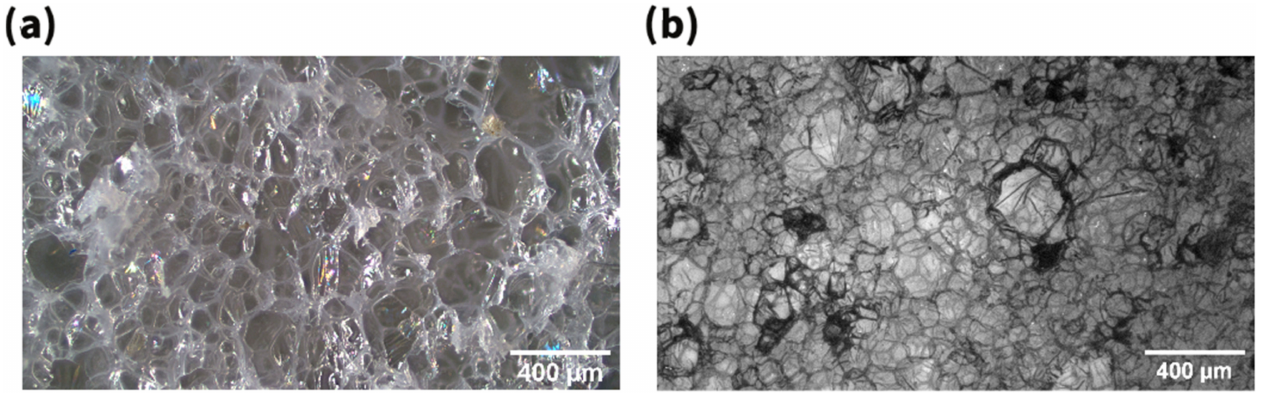
Figure 10. PB-1 foam obtained with a P drop of 49 bar ( a ) and of 99 bar ( b